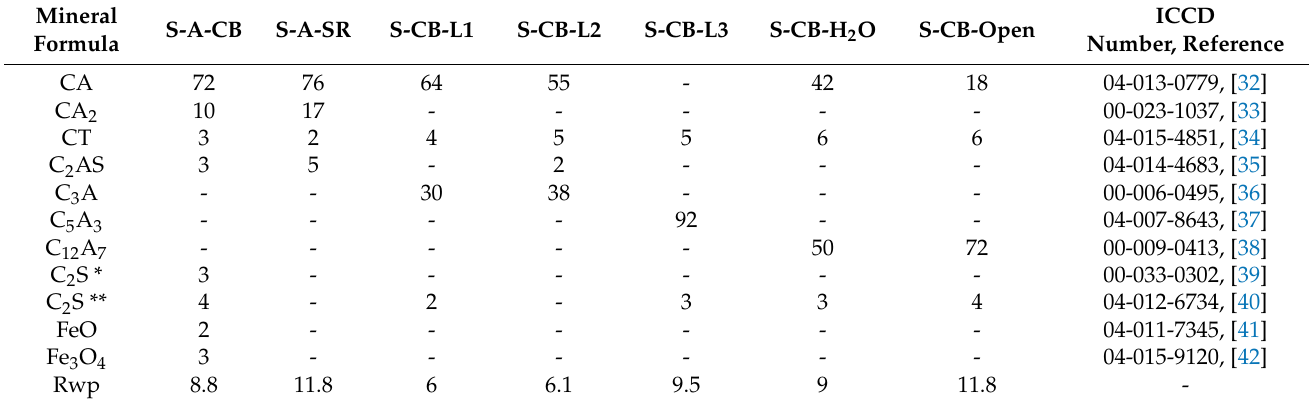
Table 3. Semi-quantitative Rietvelt analysis of selected slag samples.